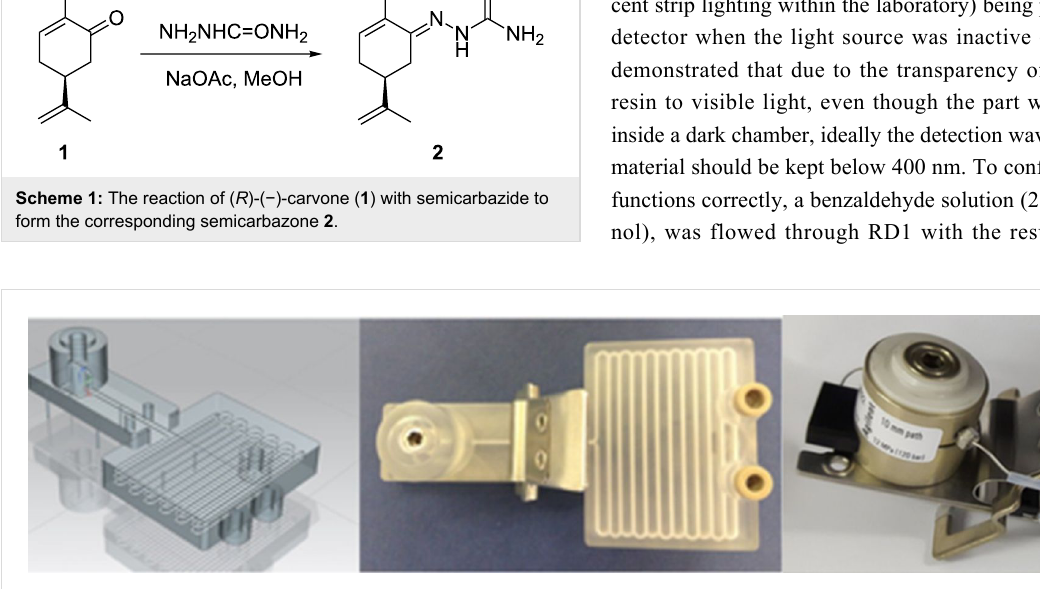
Figure 1: CAD model of SL reactor design RD1 (left), RD1 with attached sprung clip (centre), commercially available Agilent flow cell (right). External dimensions of RD1 are 123 (length) × 67 (width) × 42 mm (depth).